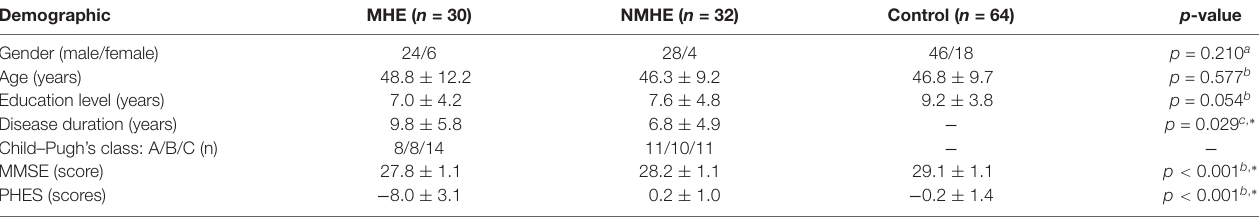
TABLE 1 | Demographic and clinical characteristics in cirrhotic patients with or without minimal hepatic encephalopathy (MHE) and normal controls. Demographic MHE ( n = 30) NMHE ( n = 32) Control ( n = 64) p -value Gender (male/female)